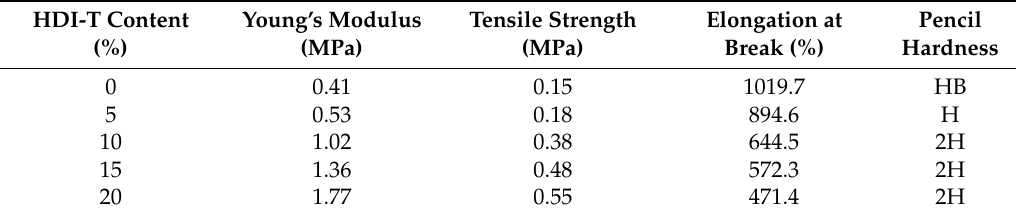
Table 4. Mechanical properties of SPU films with different HDI-T contents.